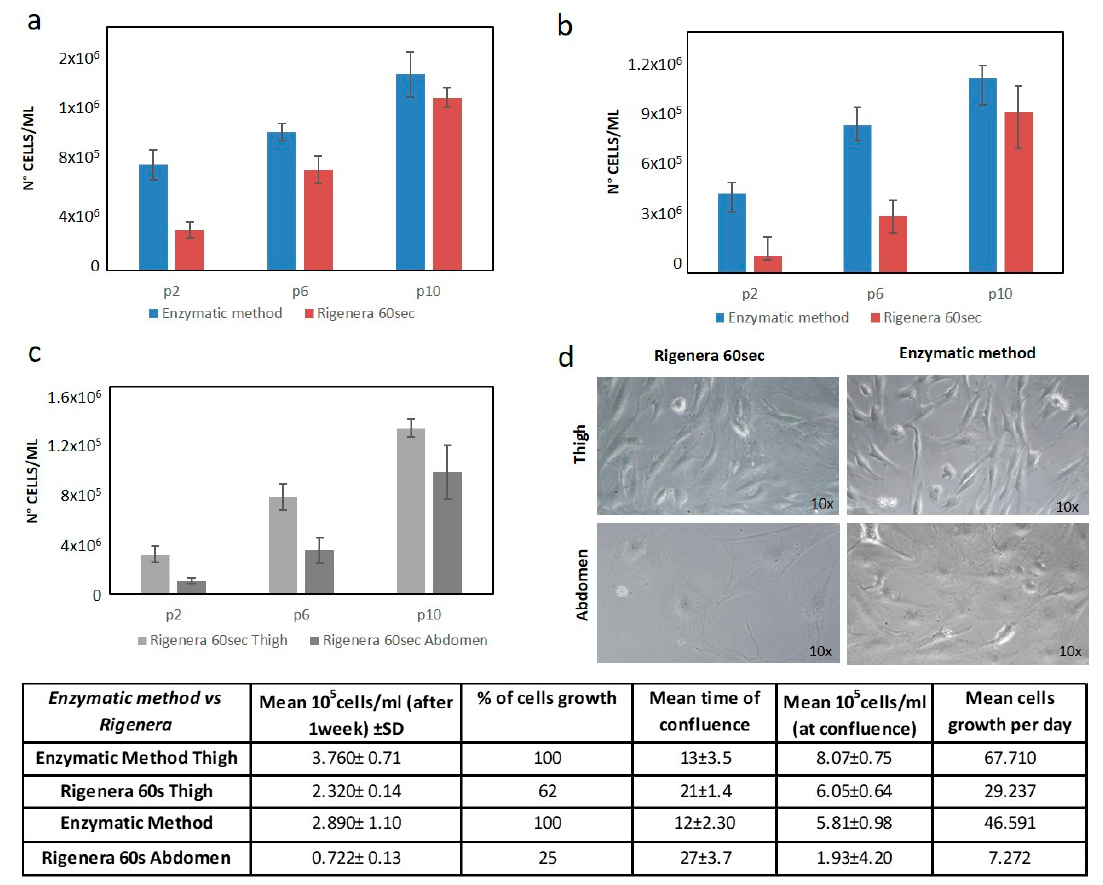
Figure 3. Comparison of Rigenera ® and the enzymatic method. ( a ) Growth rate comparison of ASCs from Rigenera ® extracted from the thigh and the enzymatic method. ( b ) Growth rate comparison of ASCs from Rigenera ® extracted from the abdomen and the enzymatic method. ( c ) Growth rate comparison of ASCs extracted with Rigenera ® from the thigh and abdomen. ( d ) Microscopic images (resolution 10 × ) of ASCs at high passages (p10). The tab shows all of the results obtained.